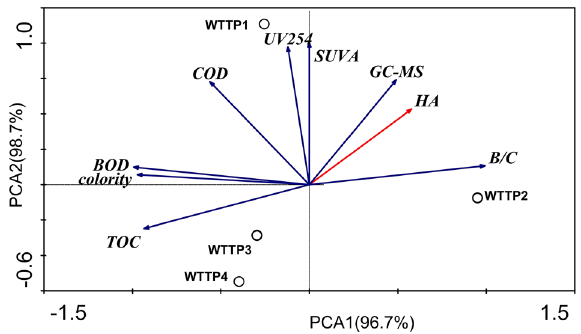
Figure 9. PCA analysis of correlation between humic acid and other